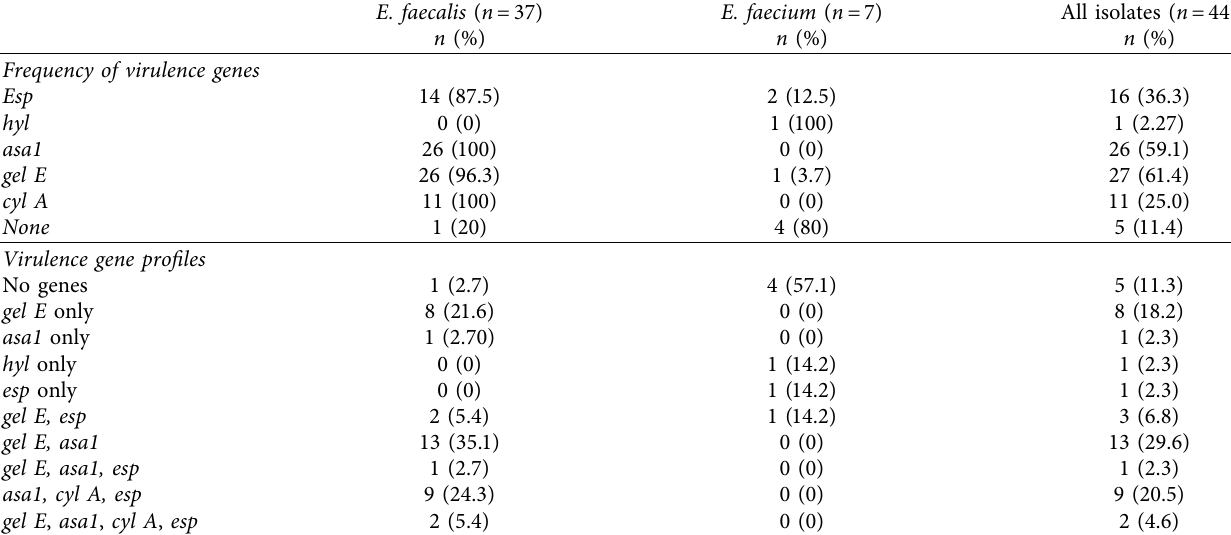
Table 2: Frequency and profles of virulence genes for E. faecalis and E. faecium